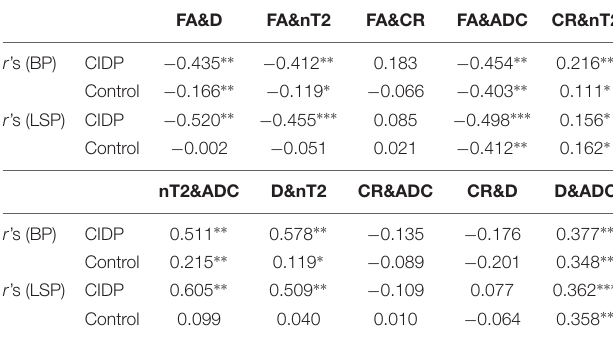
TABLE 4 | Spearman correlation coefficients among multiparameters 4 .